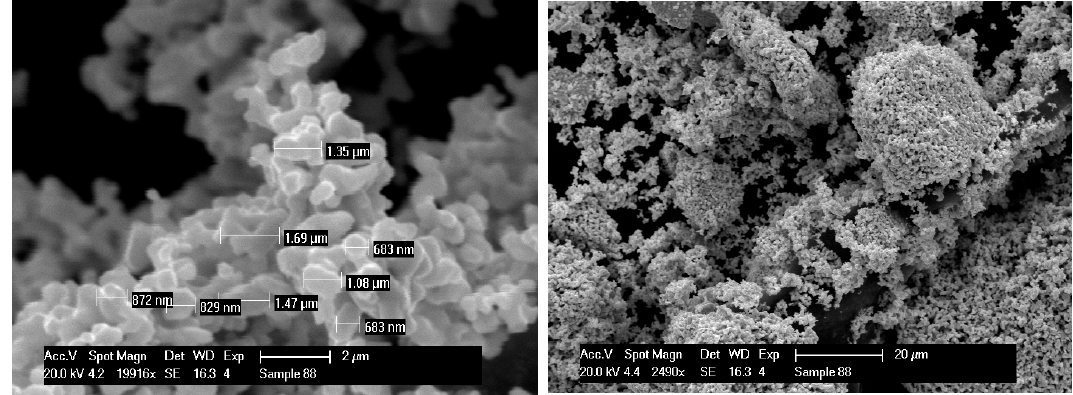
Figure 11. SEM analysis of the 100 Mo commercial powders of Isoflex (USA).